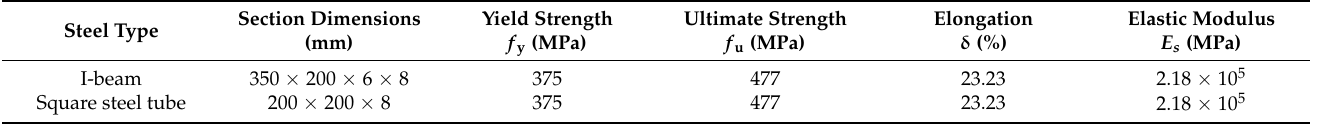
Table 3. Sections and material mechanical properties of the structural components of the steel